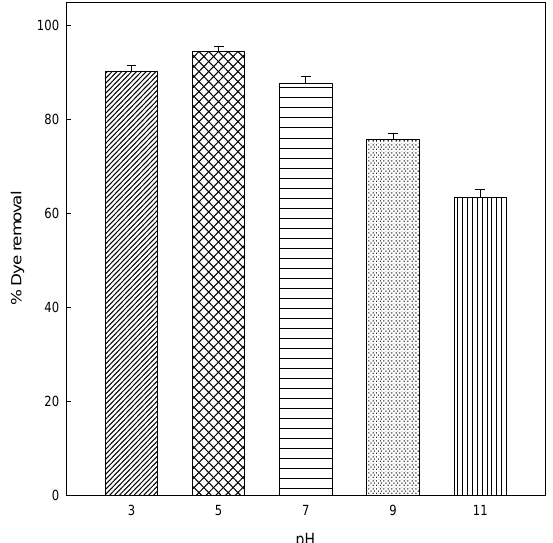
Figure 2. Effect of pH on the adsorption of DB78 by eggshell at different pH values. Figure 2. E ff ect of pH on the adsorption of DB78 by eggshell at di ff erent pH